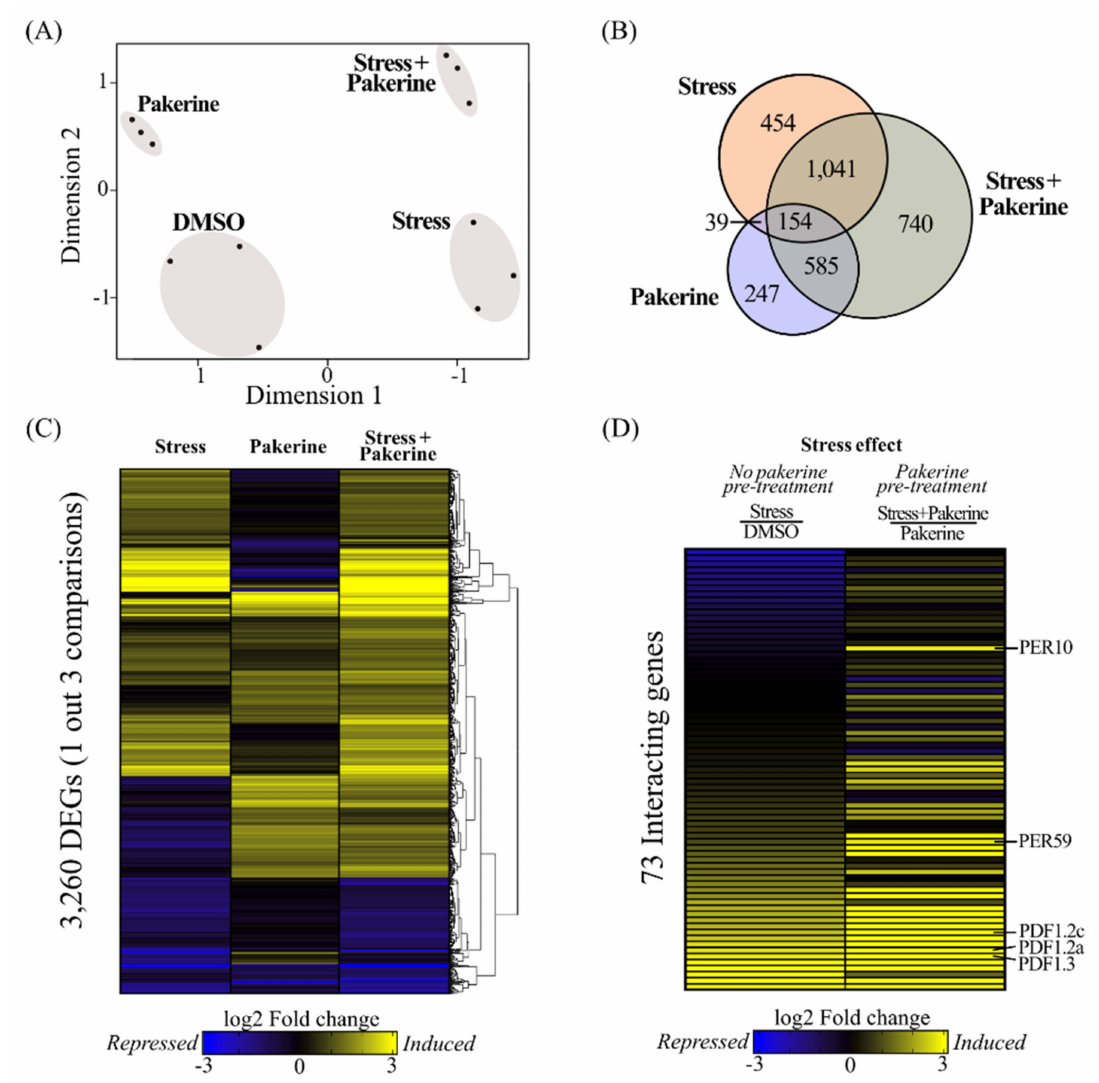
Figure 2. Rearrangement of gene expression in cat2-2 plants upon photorespiratory stress in the presence of pakerine. ( A ) Multidimensional scaling plot of transcriptome profiles of cat2-2 mutant plants treated with pakerine or DMSO before and after exposure to photorespiratory stress. “DMSO”: DMSO-treated plants under control conditions; “Pakerine”: pakerine-treated plants under control conditions; “Stress + Pakerine”: pakerine-treated plants exposed to photorespiratory stress; “Stress”: DMSO-treated plants exposed to photorespiratory stress. ( B ) Venn diagram depicting the overlap between di ff erentially expressed genes (DEGs; | Log 2 fold change (FC) | > 1, false discovery rate (FDR) < 0.01) in plants exposed to photorespiratory stress (“Stress”), pakerine-treated plants (“Pakerine”), and pakerine-treated plants exposed to photorespiratory stress (“Stress + Pakerine”) against mock-treated plants (“DMSO”). ( C ) Hierarchical average clustering of 3260 DEGs identified in at least one out of the three pairwise comparisons described in Figure 2B. ( D ) Heat map of 73 transcripts that responded to photorespiratory stress in a pakerine-specific manner according to two-way (pakerine × photorespiratory stress)